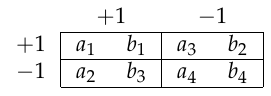
Table 1. Arbitrary Game G in Normal-Form.